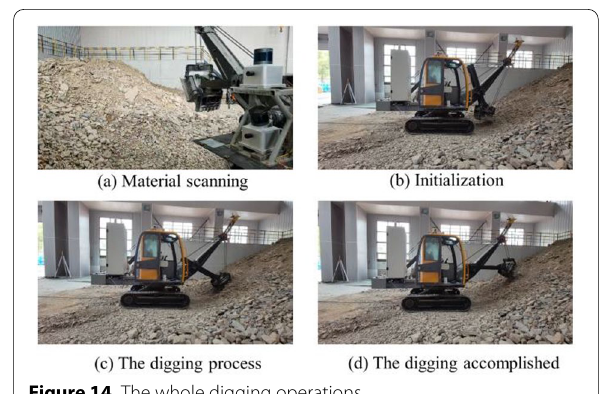
Figure 14 The whole digging operations